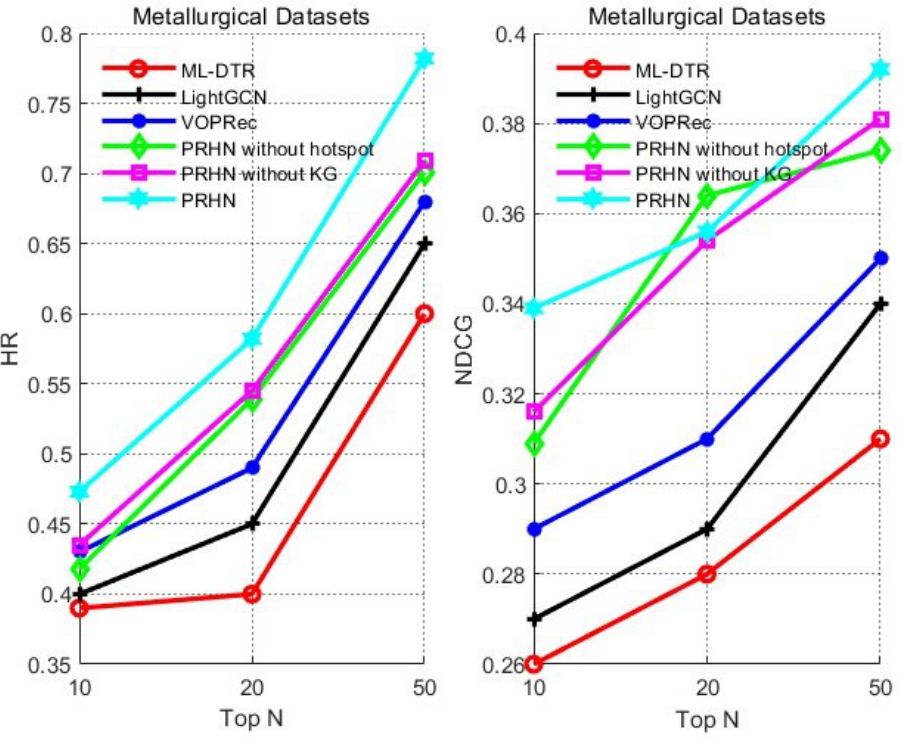
Figure 5. Performance of different models on metallurgical